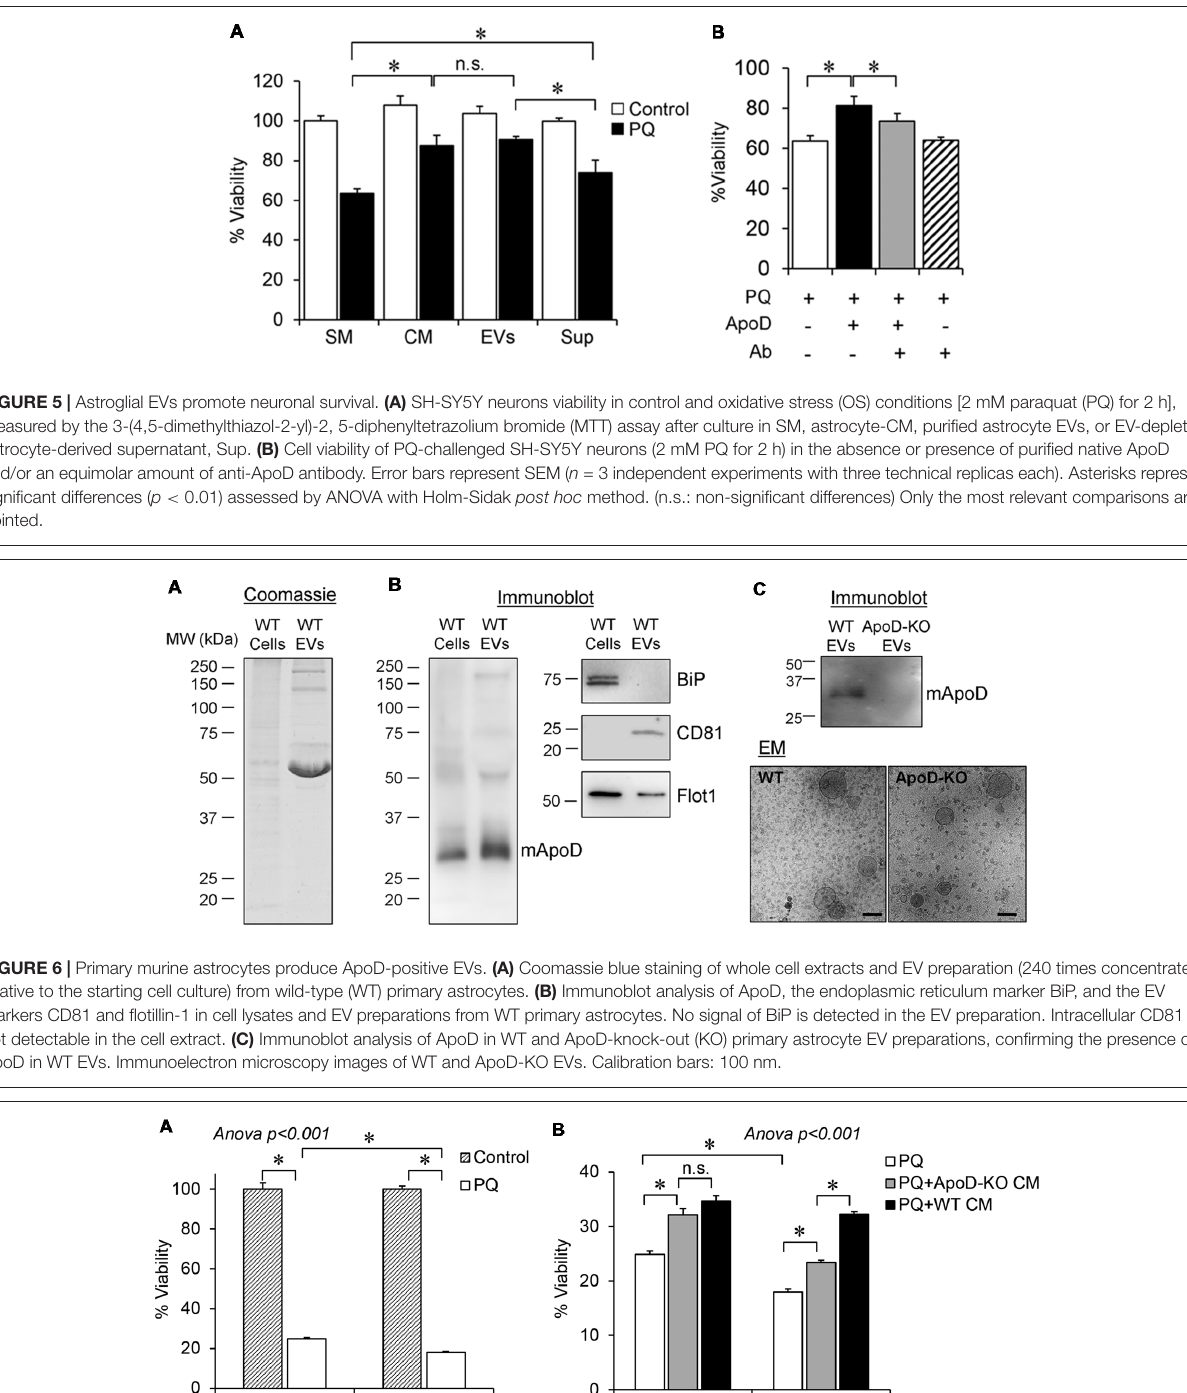
Frontiers in Cellular Neuroscience |